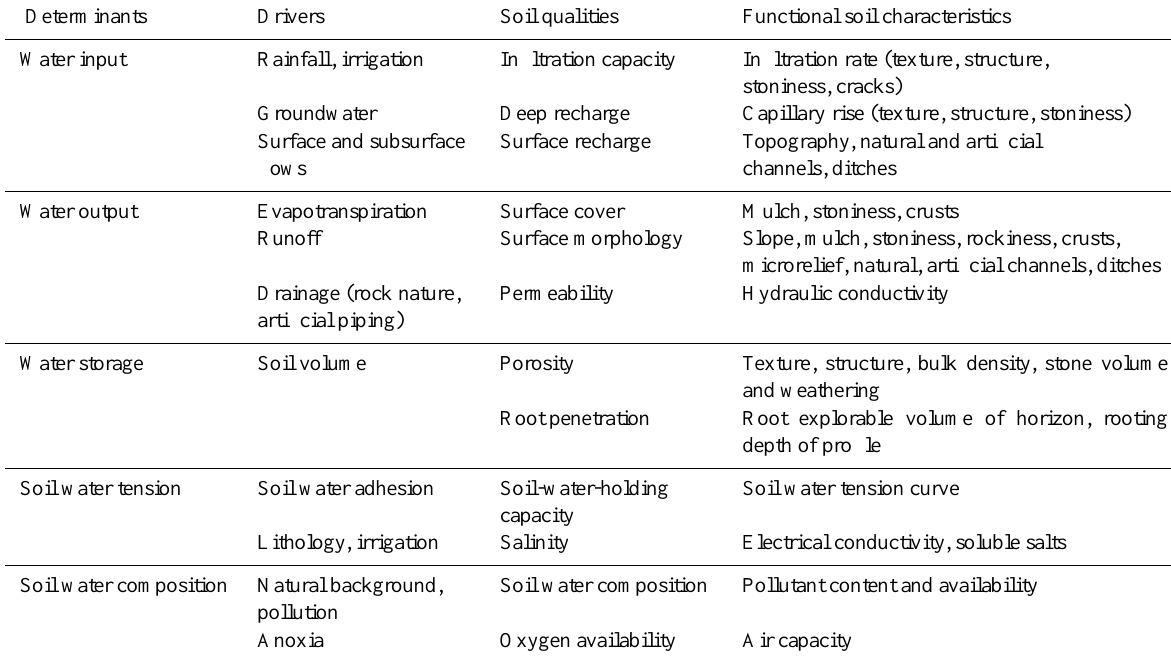
Table 3. Soil qualities related to plant-available water.